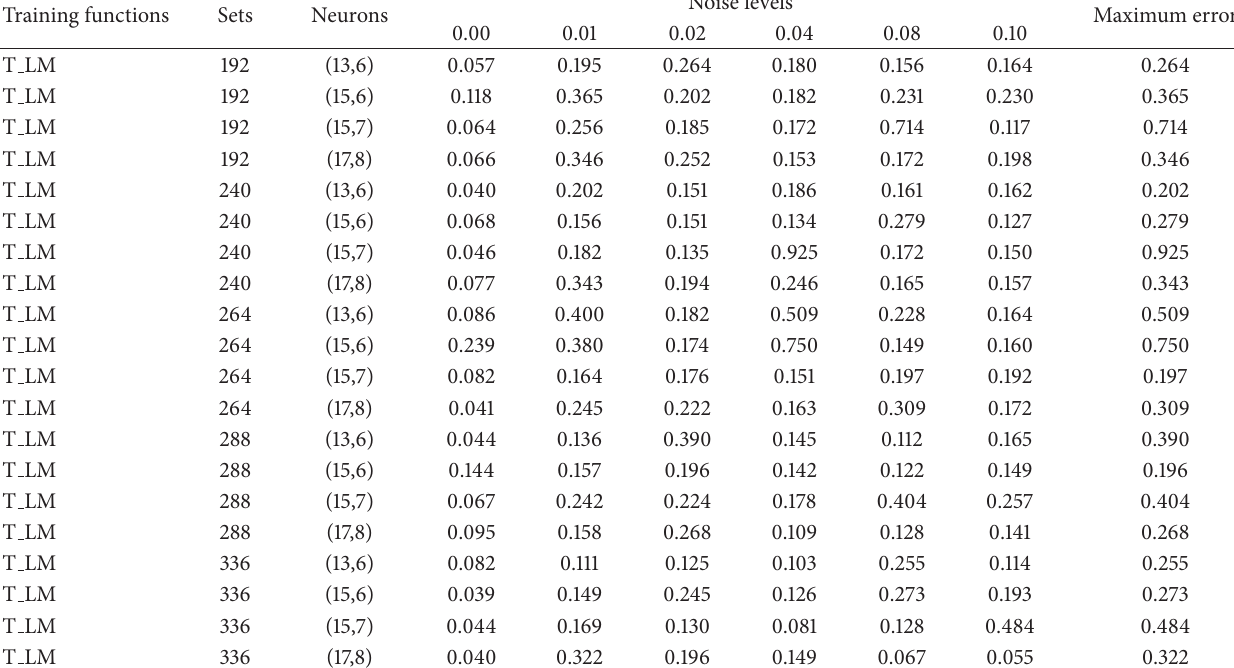
Table 15: The identification errors of neural networks based on strain damage parameters. Training functions